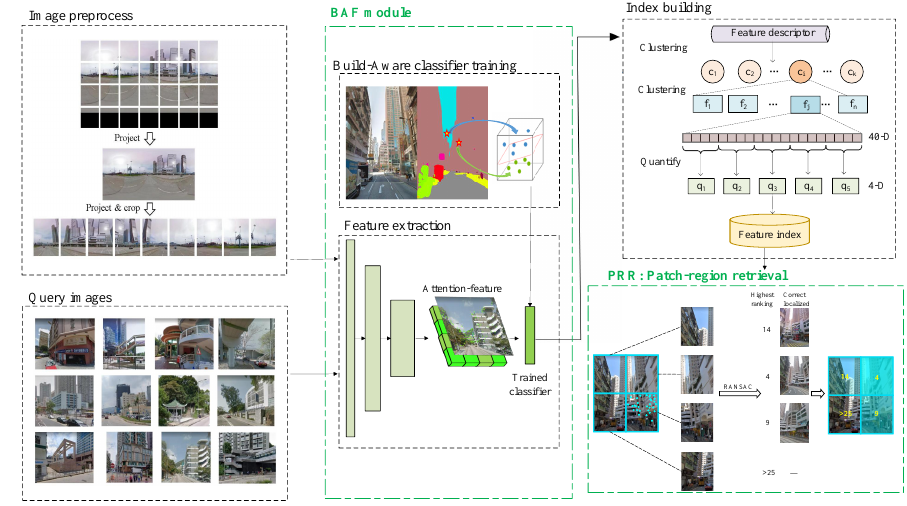
Figure 2. Technology roadmap of our whole